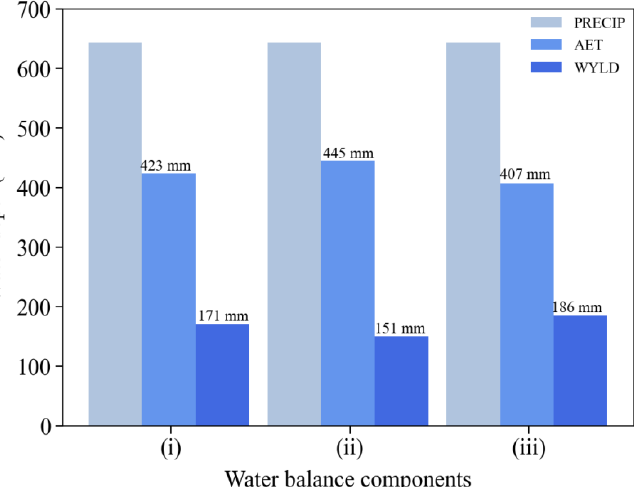
Figure 5. Water balance components; (i) Streamflow calibration, (ii) AET calibration, and (iii) Multi- variable calibration. PRECIP: Precipitation (mm), AET: Actual evapotranspiration (mm), WYLD: Water yield (mm).